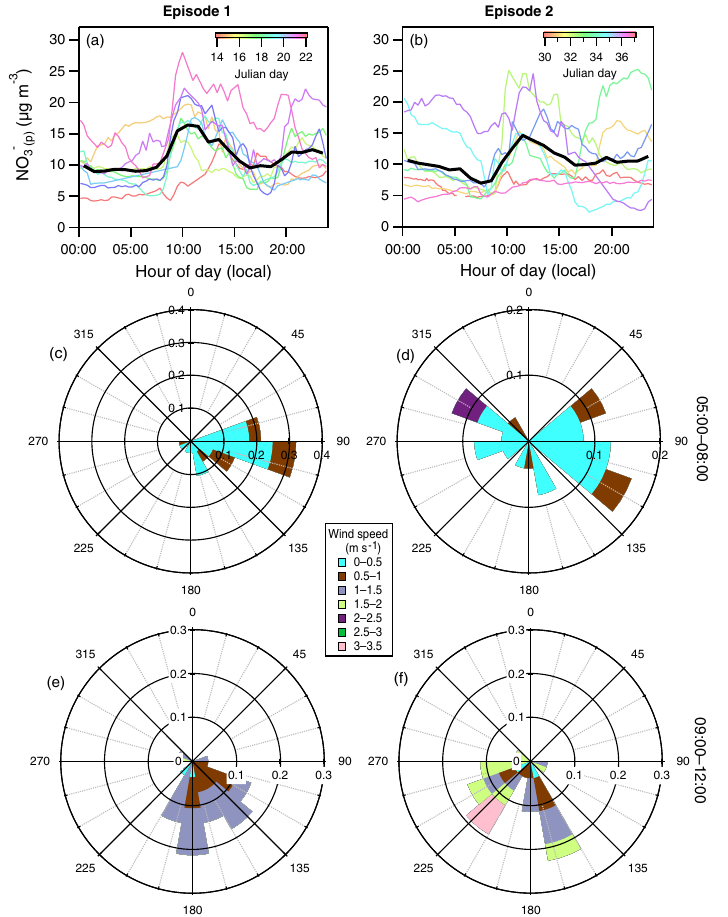
Figure 9. Panels (a, b) : diurnal variation in the surface-level particulate nitrate concentration during (a) the first episode and (b) the second episode. The solid black lines are the average profile over the episode and the colored lines are for individual days. Panels (c, d, e, f) : wind roses for surface-level (10m) winds in Fresno for the early morning (05:00–08:00LT) during (c) Episode 1 and (d) Episode 2 and for the late morning (09:00–12:00LT) during (e) Episode 1 and (f) Episode